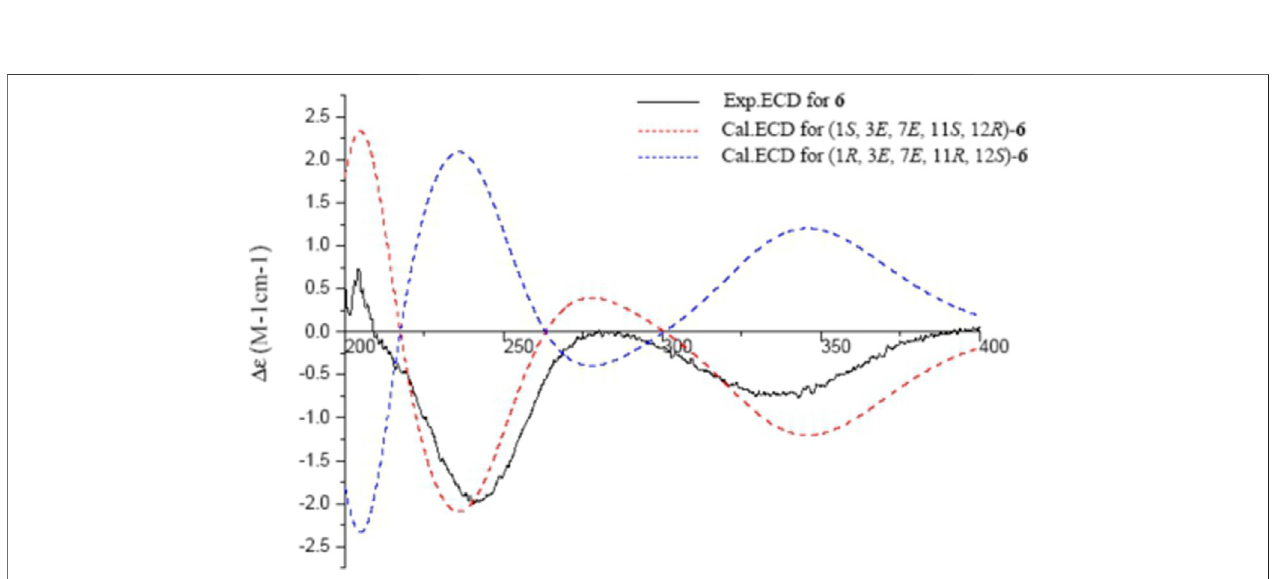
FIGURE6| Experimental and calculatedECDspectraof 4 and its enantiomer(red and bluecalculatedat the B3LYP/6 – 311++G (2d, p )//B3LYP/6 – 31+G (d, p )level in CH 3 OH; black, experimental in CH 3 OH).